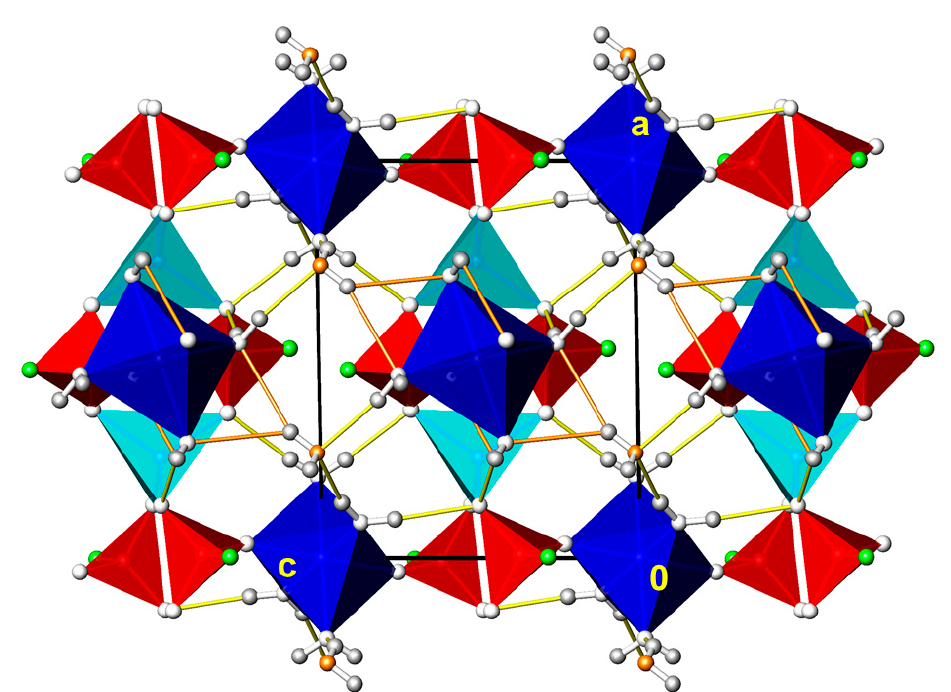
Figure 5. The crystal structure of ZnPO 3 F(H 2 O) 2.5 in a projection along [010]. Colour code of PO 3 F tetrahedra and H atoms as in Figure 1; [ZnO 6 ] octahedra are given in dark-blue, [ZnO 4 ] tetrahedra in turquoise and the O atom of the crystal water molecule as an orange sphere. O–H···O hydrogen bonding with the aqua ligands as donor groups is given as yellow lines, and involving the crystal water molecules as donor groups as orange lines.